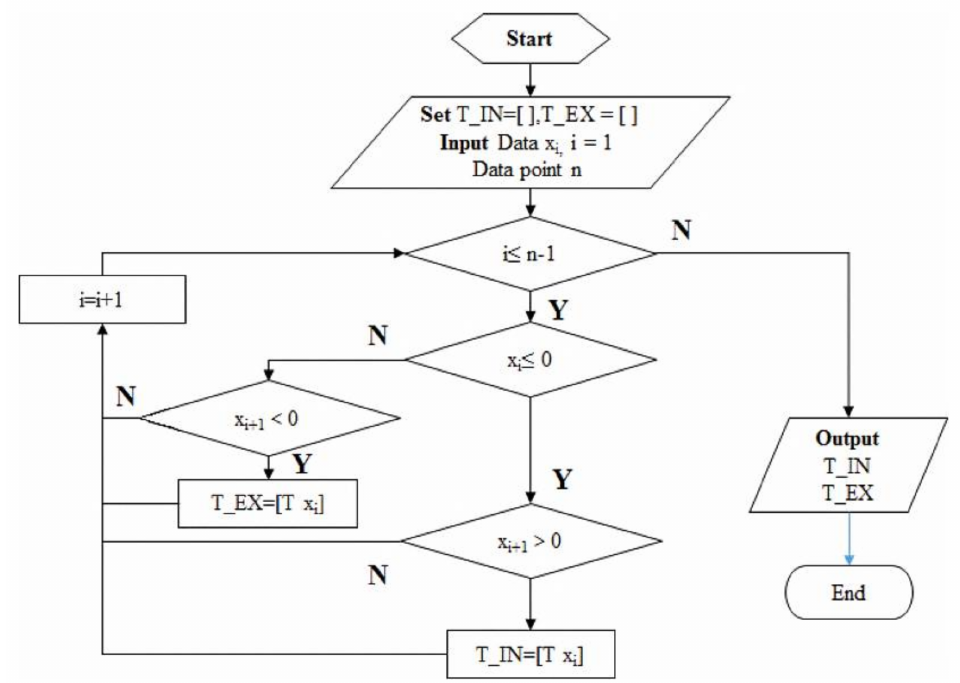
Figure 13. Flowchart of the algorithm to identify the starting points of inhalation and exhalation from the intersection of the respiration signal with the time axis